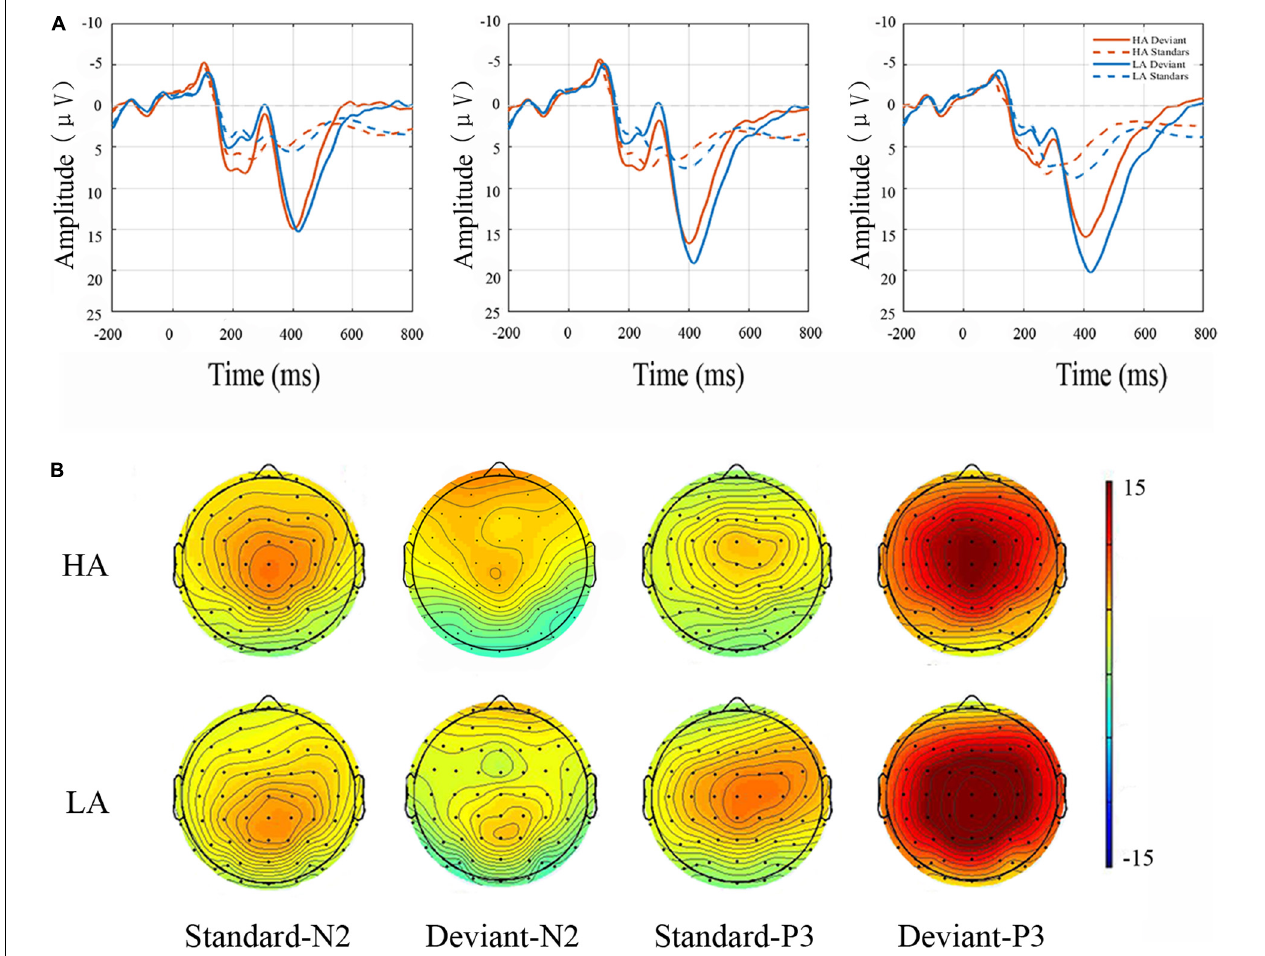
FIGURE 3 | Top panel (A) N2 and P3 grand average amplitudes. Event-related potential (ERP) responses elicited to standard and deviant conditions at frontocentral sites (i.e., Fz, FCz, and Cz) for LA and HA groups. Bottom panel: topographic maps (B) . Scalp distributions are time-locked to the grand average amplitudes of N2 and P3 components in the standard and deviant conditions.